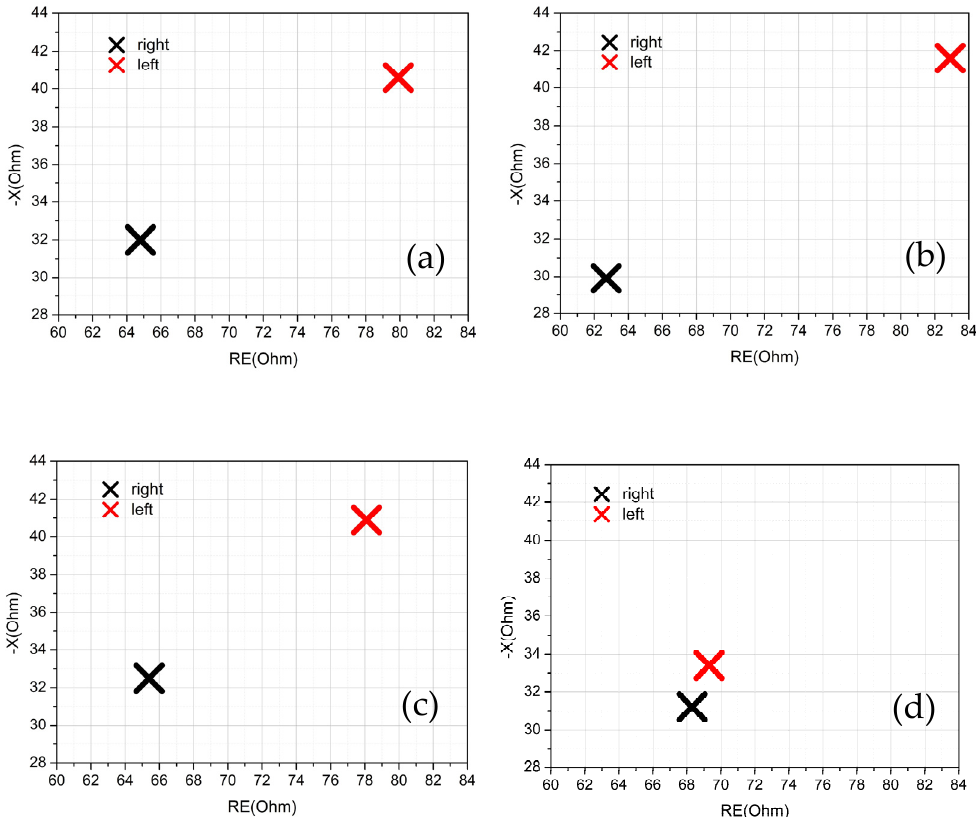
Figure 11. Reactance vs. resistance for left (injured) knee and right (healthy) knee. ( a ) Acute phase of injury, ( b ) situation Figure 11 . Reactance vs resistance for left (injured) knee and right (healthy) knee. (a) acute phase of after two weeks from ( a ), during which the subject performed heavy sport activity, ( c ) situation after another 10 days of injury; (b) situation after two weeks from (a), during which the subject performed heavy sport activity; training, during which the subject tried to load less on the leg in pain, ( d ) situation after about 3 months of less stressful (c) situation after another 10 days of training, during which the subject tried to load less on the leg in activity for the joints (walking and swimming) and ice pain; (d) situation after about 3 months of less stressful activity for the joints (walking and swimming) and ice therapy.